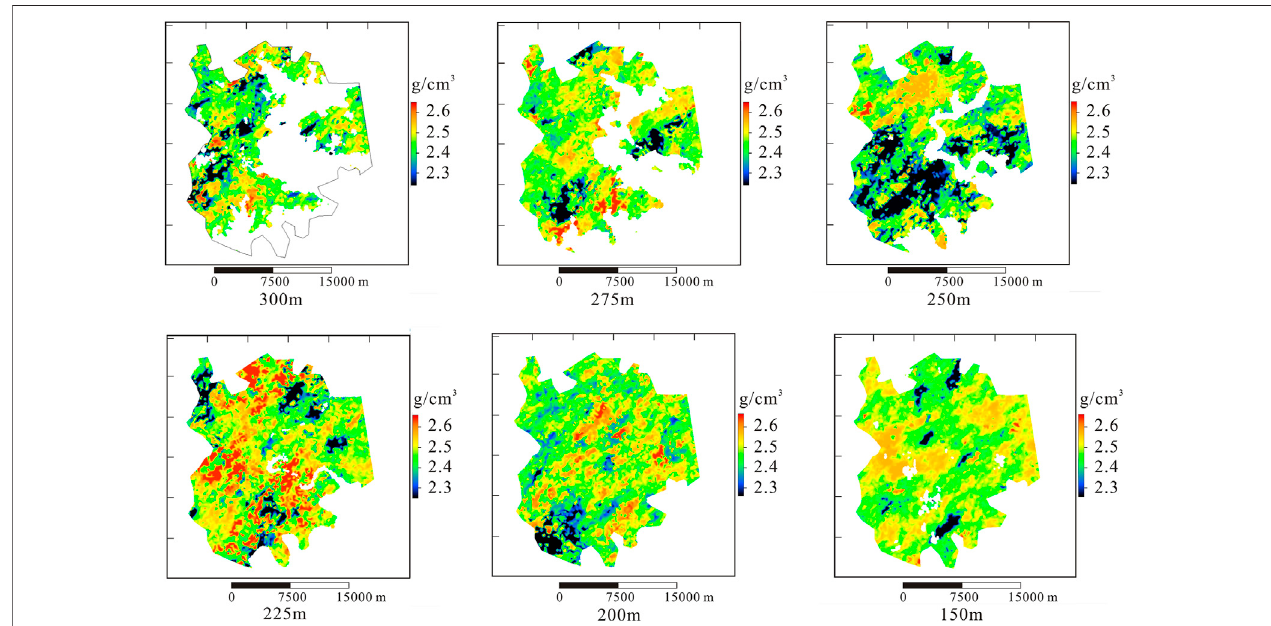
FIGURE 9 | Horizontal slices of the geotechnical model in different elevations (considering density as an example).